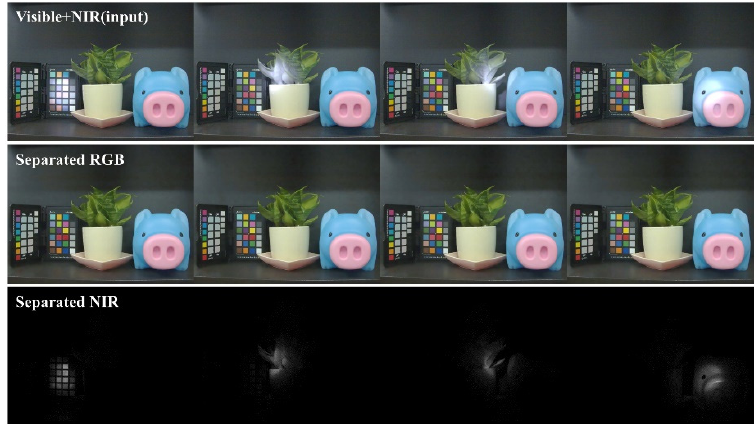
Figure 7. The separation experimental result under fluorescent and 850 nm NIR spot light illuminating four different locations from left to right.